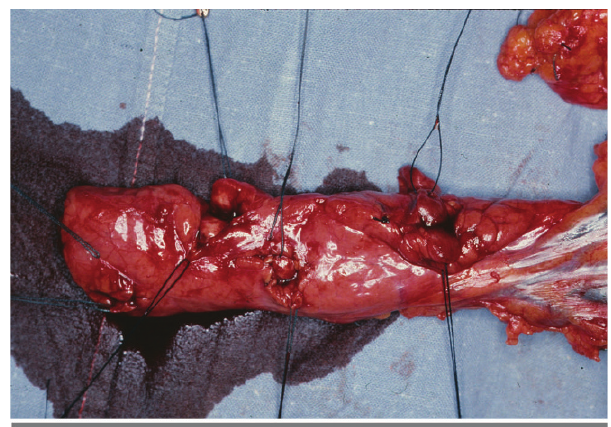
Figure 3 - Distal pancreatectomy in a patient with insulinomas associated with multiple endocrine neoplasia type 1. Eleven small tumors were found. Serum glucose returned to normal